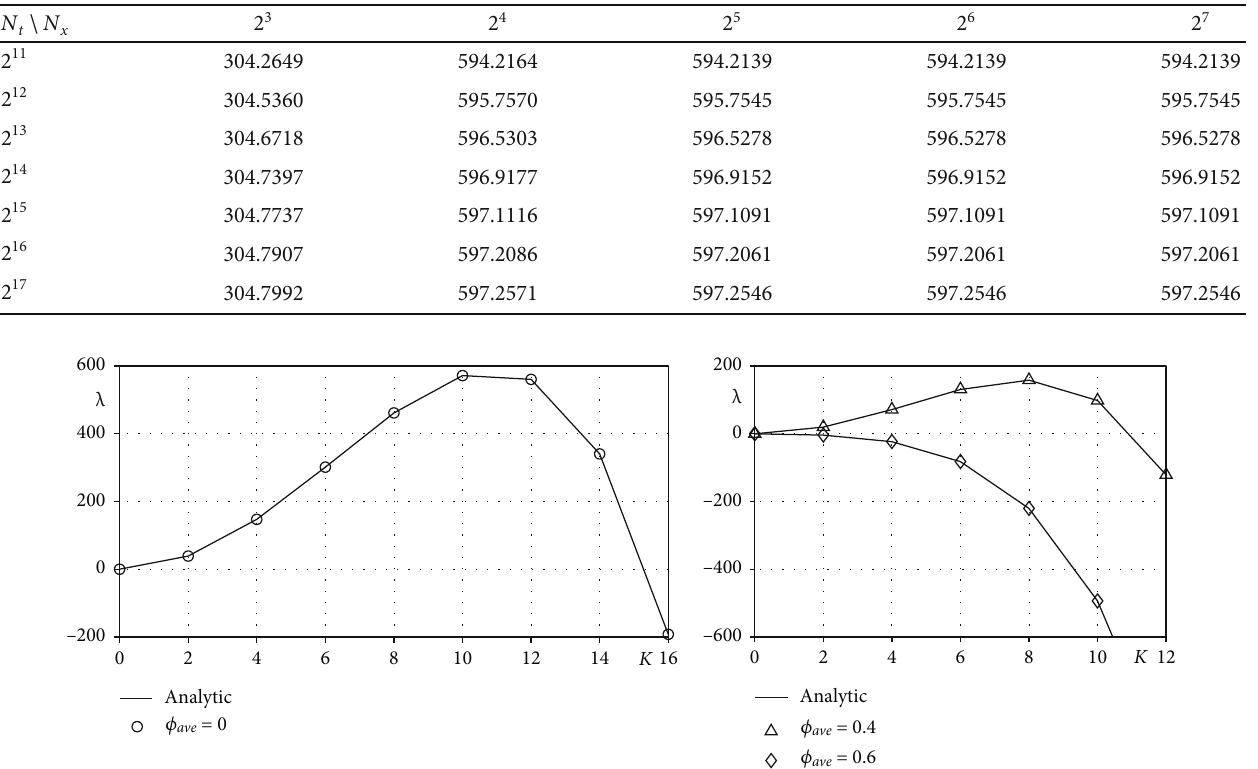
Table 1: Numerical growth rate for various Δ t and h at T = 0 : 004 ( λ = 597 : 3241 ).